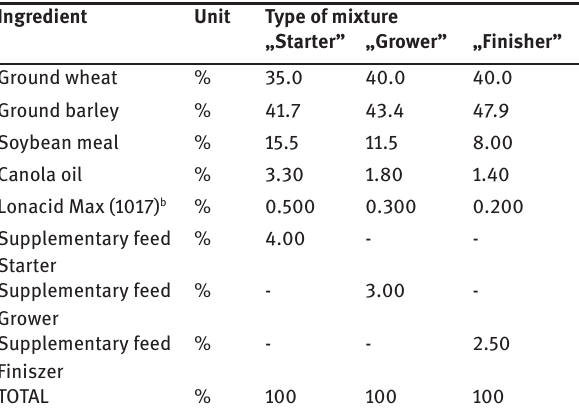
Table 2 : The chemical composition of feed mixtures for growing pigs.